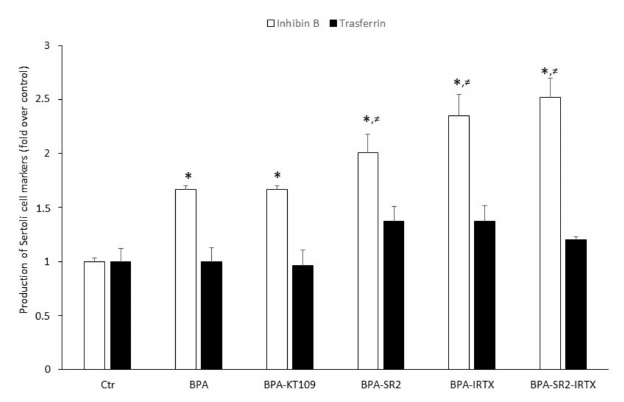
Figure 5. Production of inhibin B and transferrin by mouse Sertoli cells. Cells were cultured for 48 h in the presence of vehicle (Ctr), or of 0.5 µ M BPA alone or with 1 µ M of KT109, SR144528 (SR2), IRTX, SR2 + IRTX. Results of 3 independent experiments were expressed as fold increase over controls, posed equal to 1.0. * p < 0.05 vs. Ctr; (cid:44) p < 0.05 vs. BPA-treated